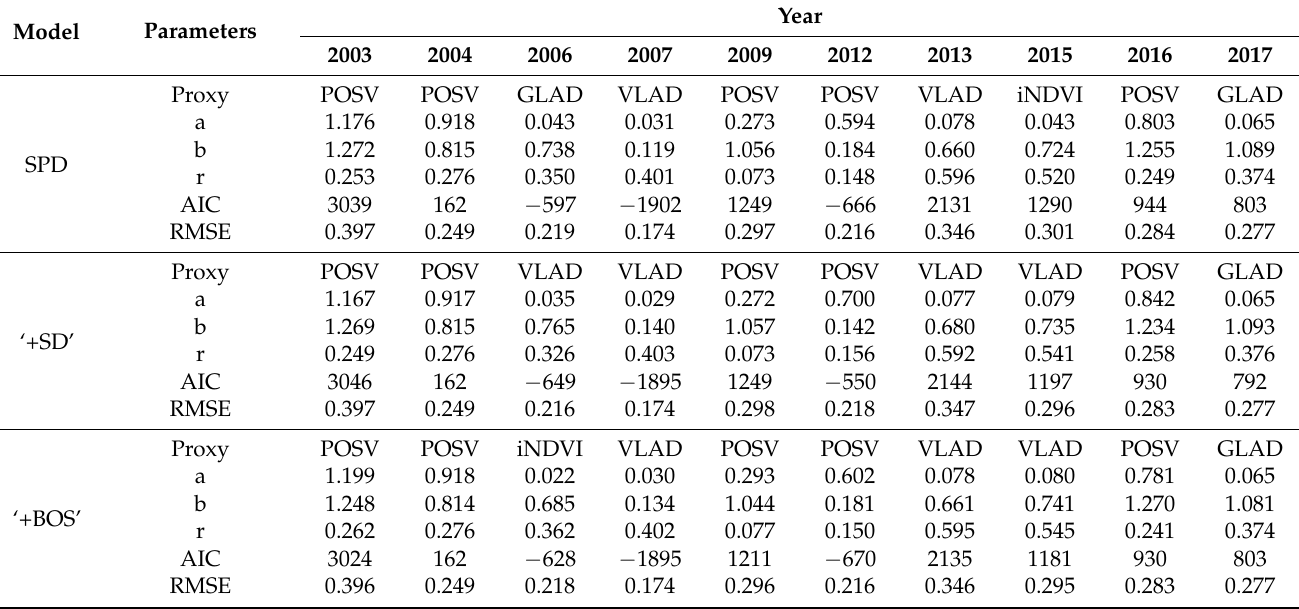
Table 3. For statistical phenology detection (SPD), statistical phenology detection incorporates sowing date (+SD) and statistical phenology detection incorporates break of season (+BOS), the integrated NDVI metrics with minimum AIC for yield estimation, estimated yield model parameters (a,b) and accuracy statistics (r, AIC, RMSE) from 2003 to 2017. Model